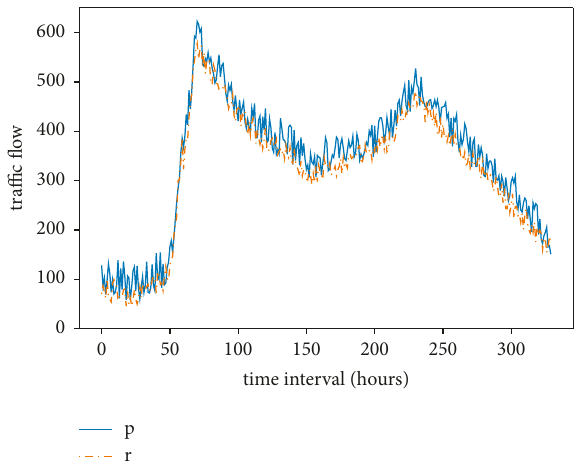
Figure 2: Prediction result on PEMS04.